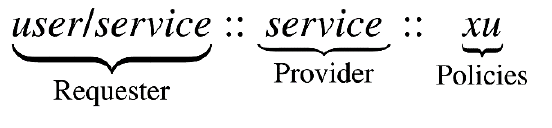
Fig. 13. Access Control Policy Structure